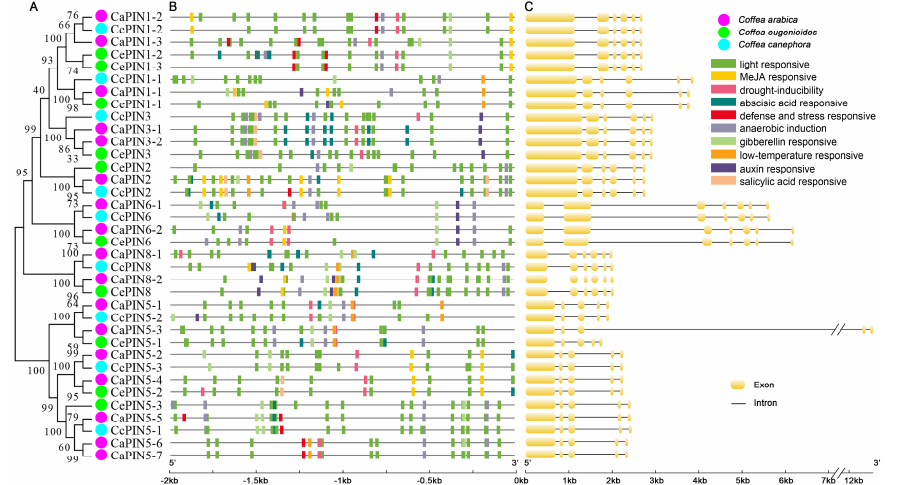
Figure 2. Cis -element ( A ) and intron ( B ) analyses of the coffee PIN family. The cis -element analysis was conducted with 2kb upstream from the initiation codon using PlantCARE software. The intron analysis was carried out with genomic and coding sequences of the coffee PIN family.